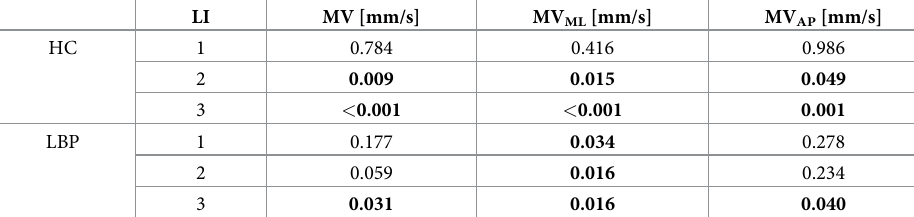
Table 2. Statistical analysis between the first and last minute of